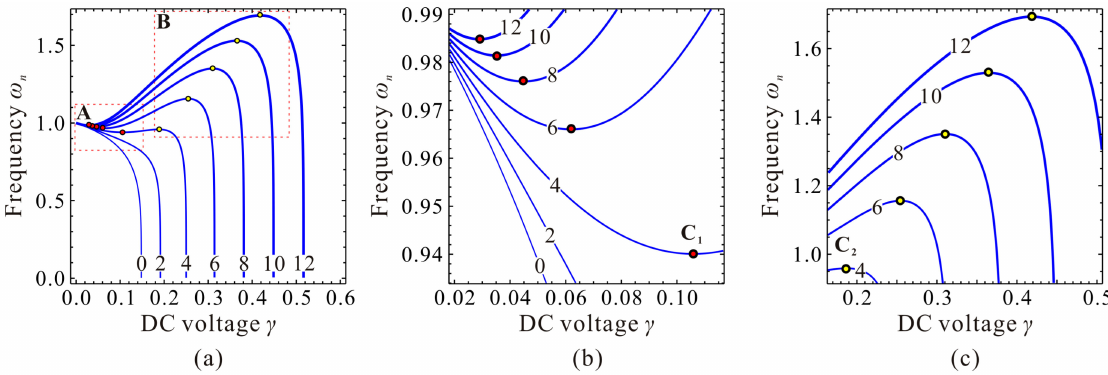
Figure 4. Evolutions of the fundamental frequency ω n versus DC voltage γ for different cubic stiffness α . global view ( a ); local view in region A ( b ); local view in region B ( c